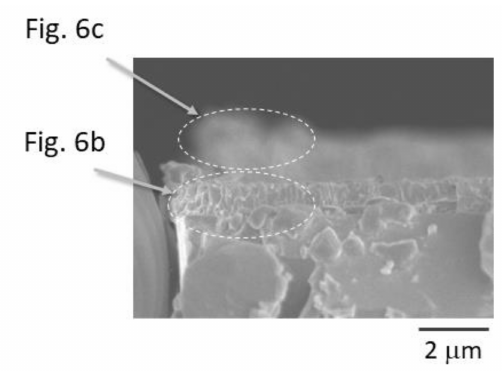
Figure 7. Side view of the X-ray-scanned sample by